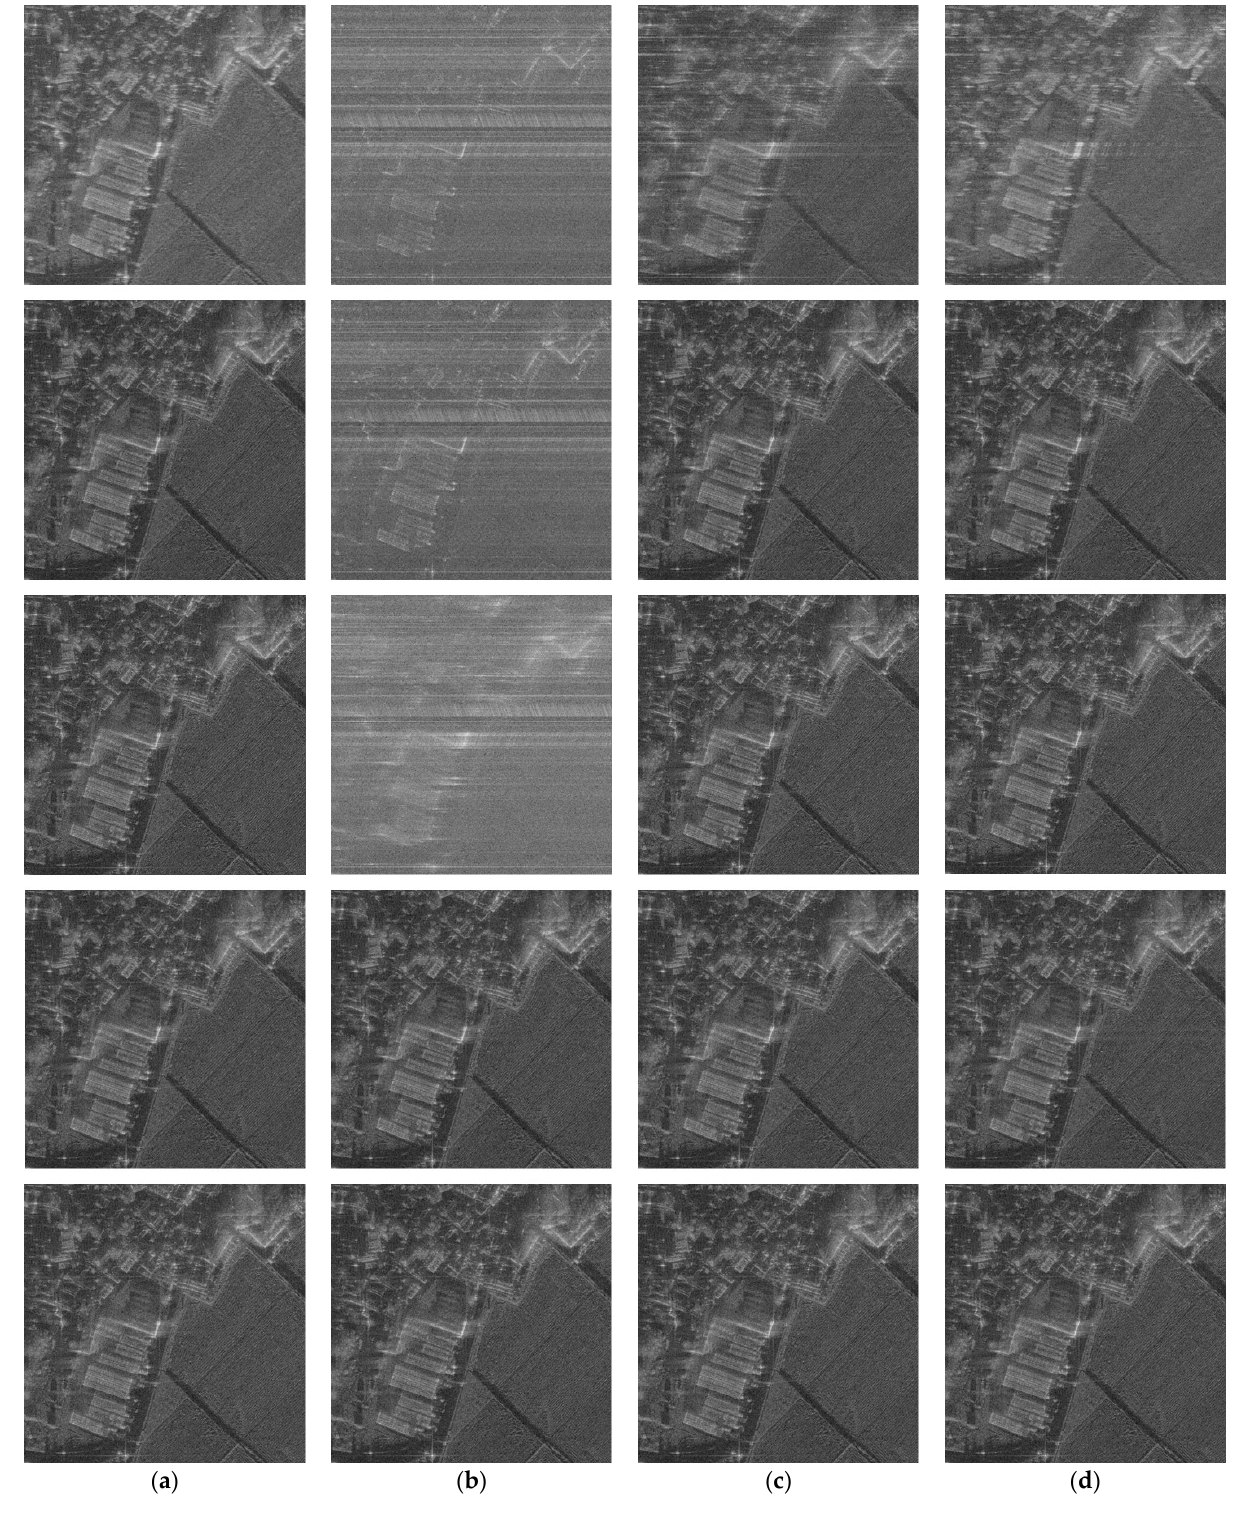
Figure 7. Phase-corrected images for different types of errors and autofocus algorithms: first row—without autofocus; second row—phase gradient autofocus (PGA); third row—generalized phase gradient autofocus (GPGA); fourth row— minimum entropy (ME); fifth row—proposed FPA. ( a ) Results for quadratic error. ( b ) Results for uniformly distributed random error. ( c ) Results for Wiener process noise. ( d ) Results for sinusoidal error with discontinuity.